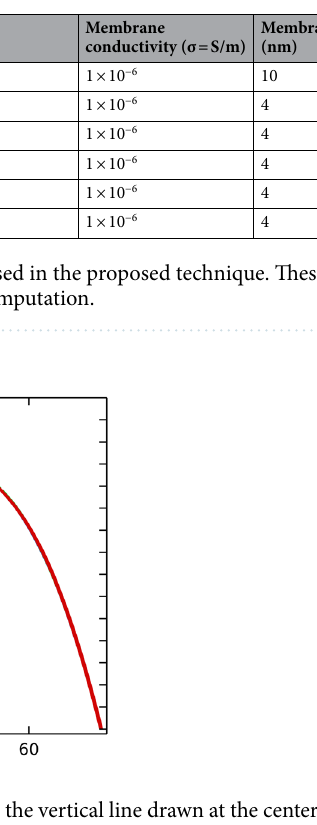
Figure 3. Velocity distribution (y-component) along the vertical line drawn at the center of the expanded region shows the velocity variation in the specified region of the microfluidic channel. Mesh convergence analysis was done with 145,046, 177,149 and 669,078 elements or grids i.e., (coarser, normal, and finer mesh settings). The line plot indicates the mesh convergence for the 1.28 µm grid